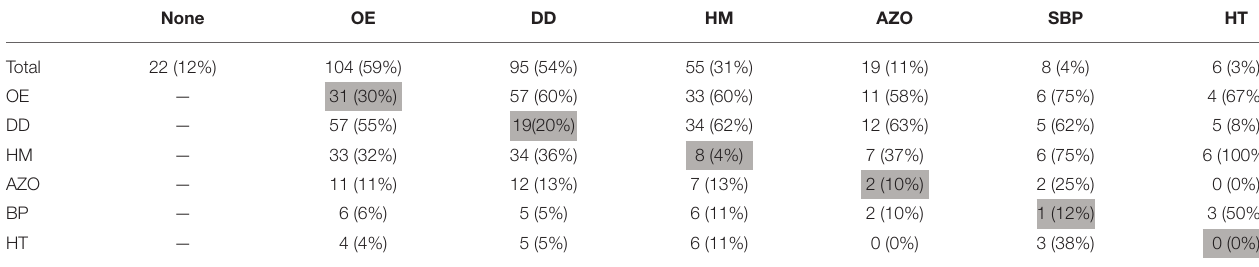
TABLE 1 | A summary morbidities found in 176 cats which completed a full clinical examination. None OE